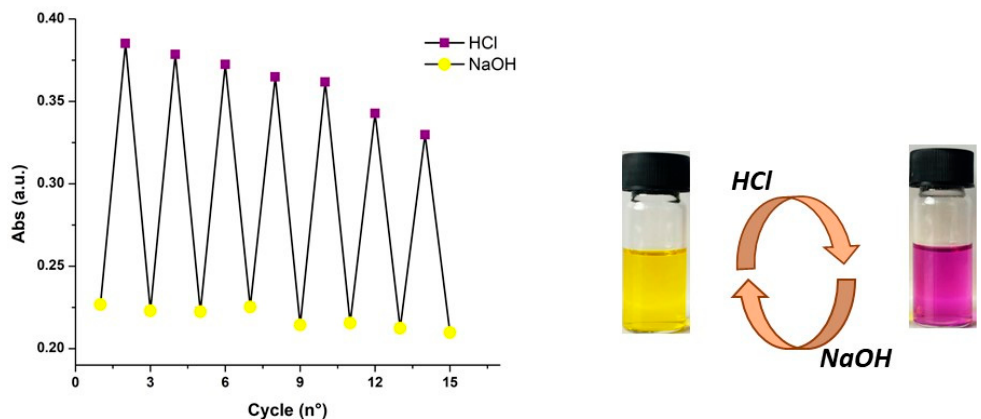
Figure 4. Changes of absorbance at 544 nm and digital pictures of 1 at 0.1 mM following repeated sequential addition of HCl and NaOH solution, up to pH 2.0 or 7.0 respectively.